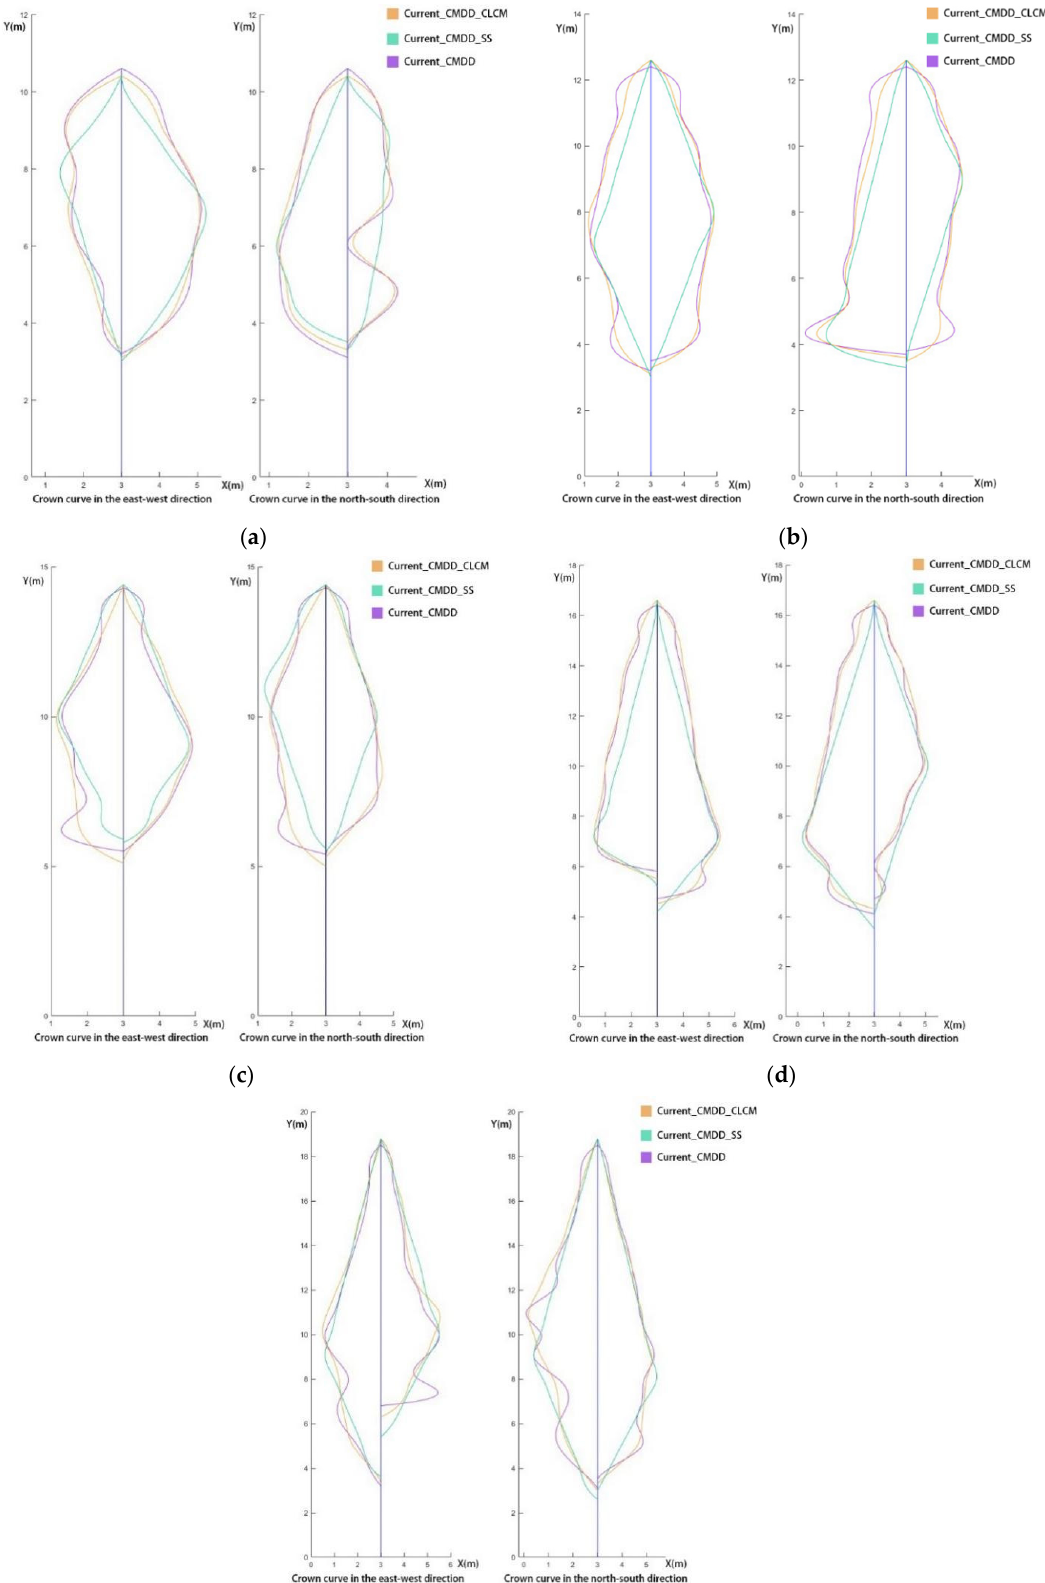
Figure 9. Identifying differences in fir canopy curves from different methods with a height of ( a ) 10